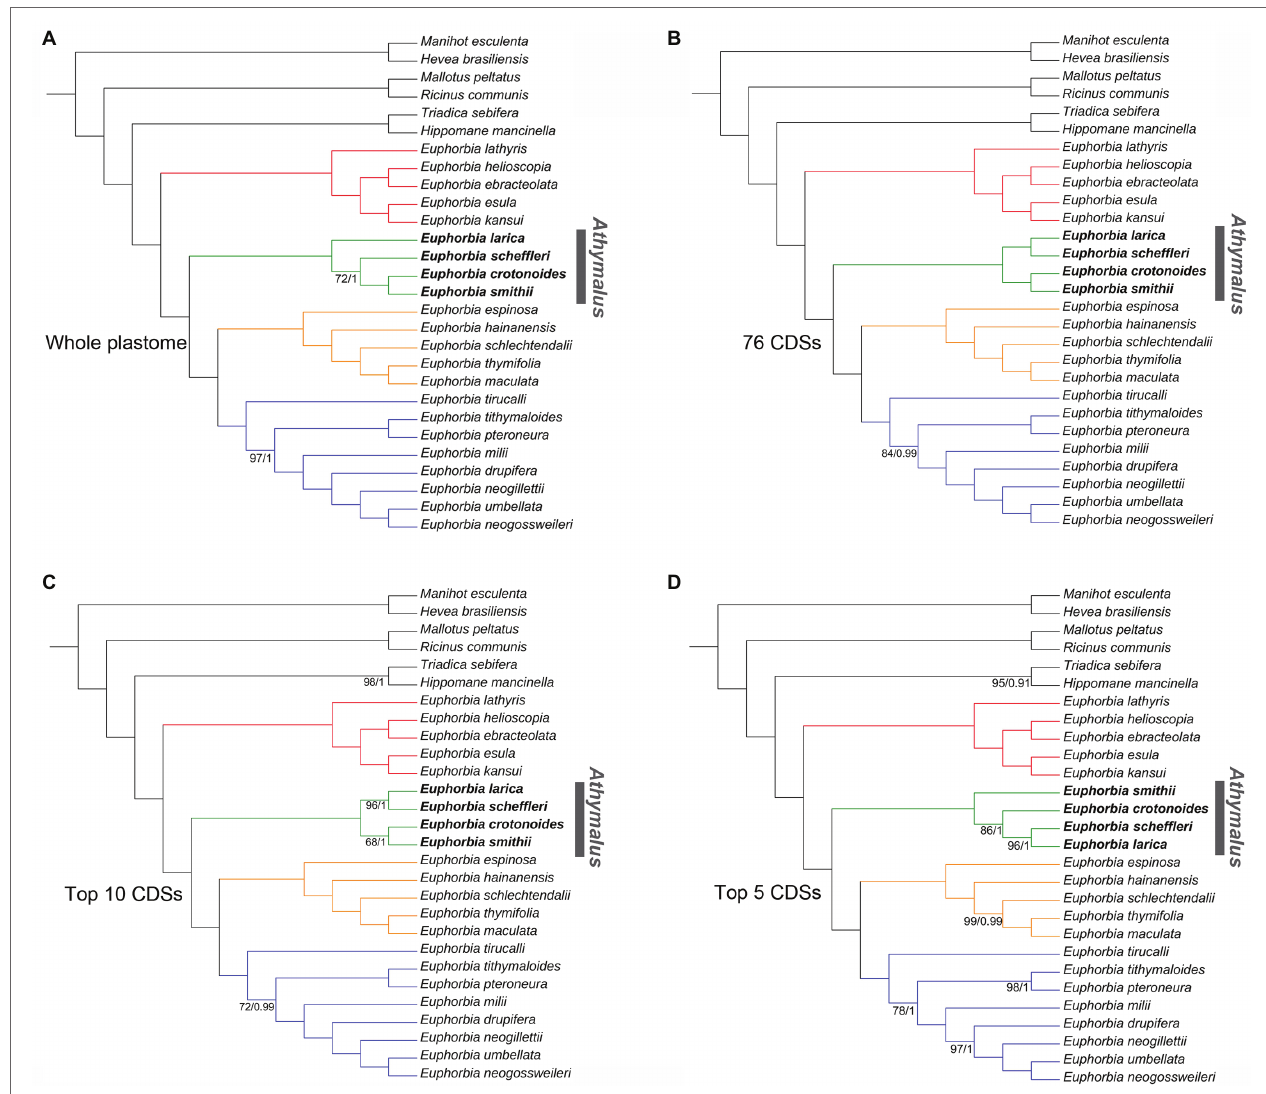
FIGURE 8 | Comparisons of phylogenetic tree topologies for four datasets based on ML and BI analyses for 28 accessions in Euphorbiaceae. Numbers below the branches are ML bootstrap values (BS)/BI PP less than BP = 100/PP = 1; all other values were fully supported. (A) Tree based on the whole plastome sequences with one of the inverted repeat regions removed. (B) Tree based on the shared 76 CDSs dataset. (C) Tree based on the 10 most informative CDSs dataset. (D) Tree based on the five most informative CDSs dataset. Subgenera Esula , Athymalus , Chamaesyce , and Euphorbia , are colored in red, green, orange, and blue, respectively. Phylogenetic incongruence among four datasets was only detected in subg. Athymalus , indicated by bold in the